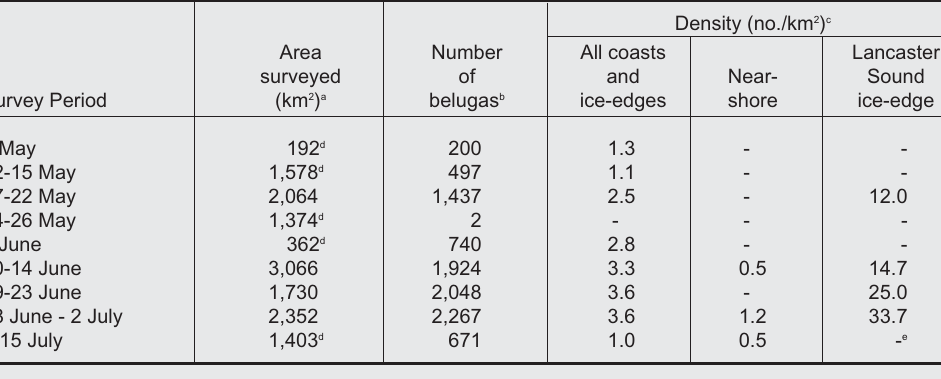
Table 3. Numbers and densities of belugas recorded during aerial surveys of northwestern Baffin Bay and eastern Lancaster Sound, 9 May-15 July 1979. The survey route is the hat- ched line on Fig. 1 (see also Fig.